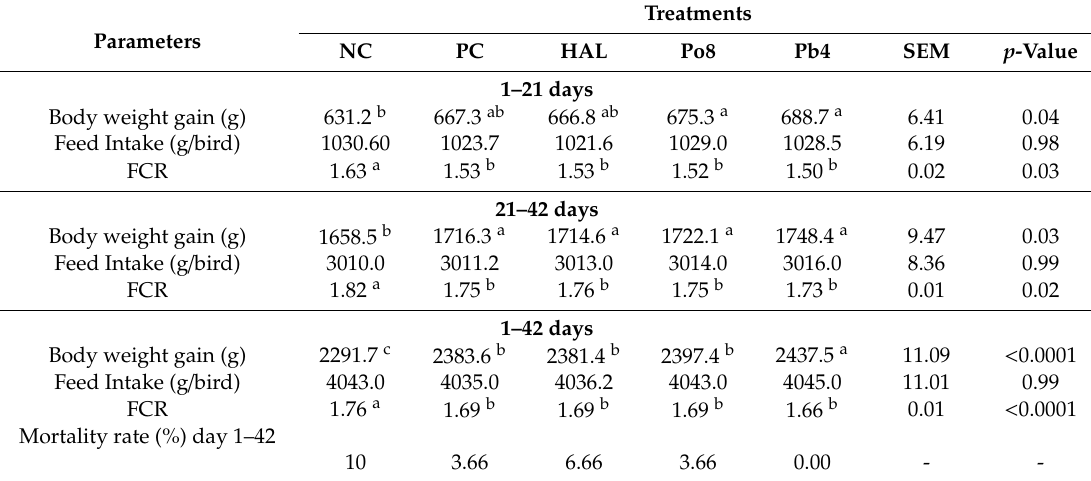
Table 2. Growth performance and mortality of broilers supplemented with phytobiotics, HAL and antimicrobial growth promoters (AGPs).